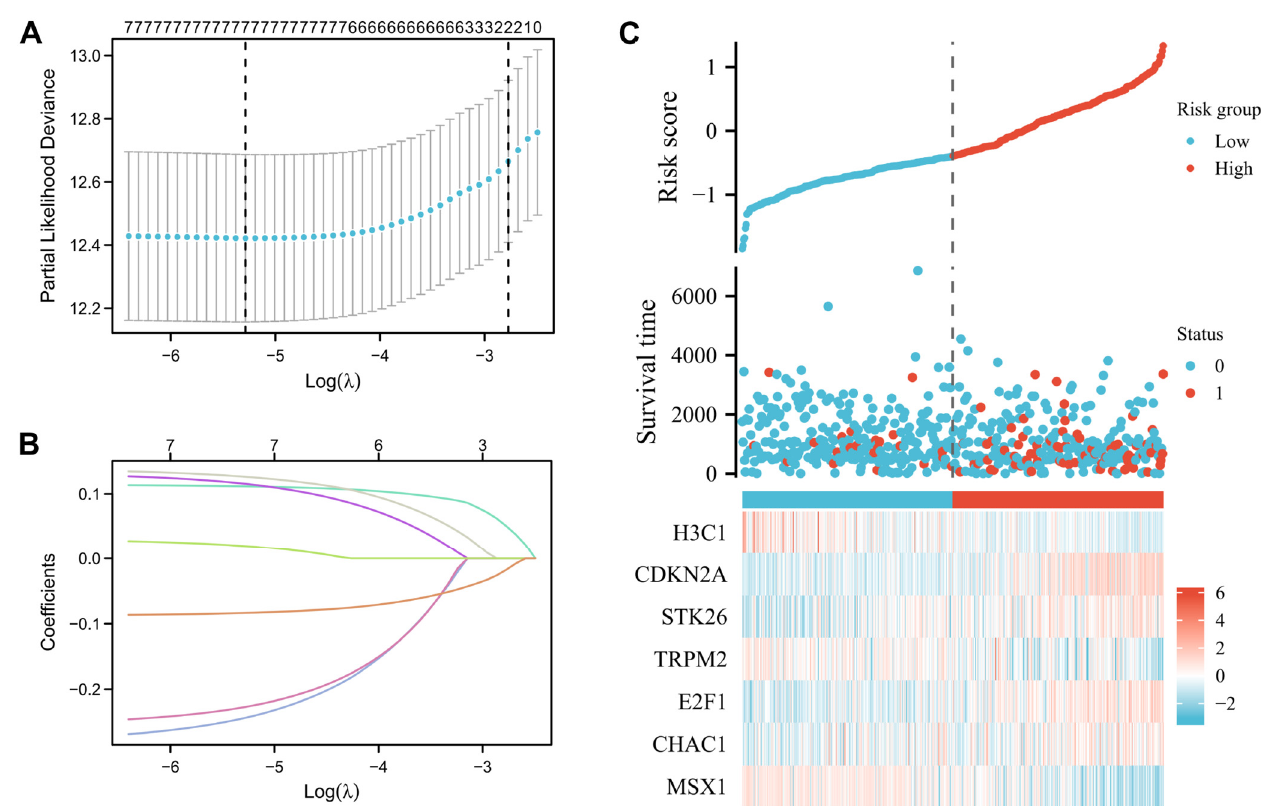
Figure 4. Construction of risk model based on the 7 oxidative stress-related DEGs: ( A ) Ten-time cross-validation for tuning parameter selection in the Lasso model; ( B ) Lasso coefficient profiles; ( C ) The risk score, survival status, and heat map of 7 oxidative stress-related DEGs in patients with UCEC. Note: UCEC: uterine corpus endometrial carcinoma; DEGs: differentially expressed genes.